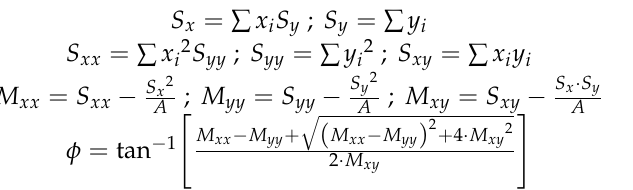
Figure 9. Distance between points P h ( a ) and points P c ( b